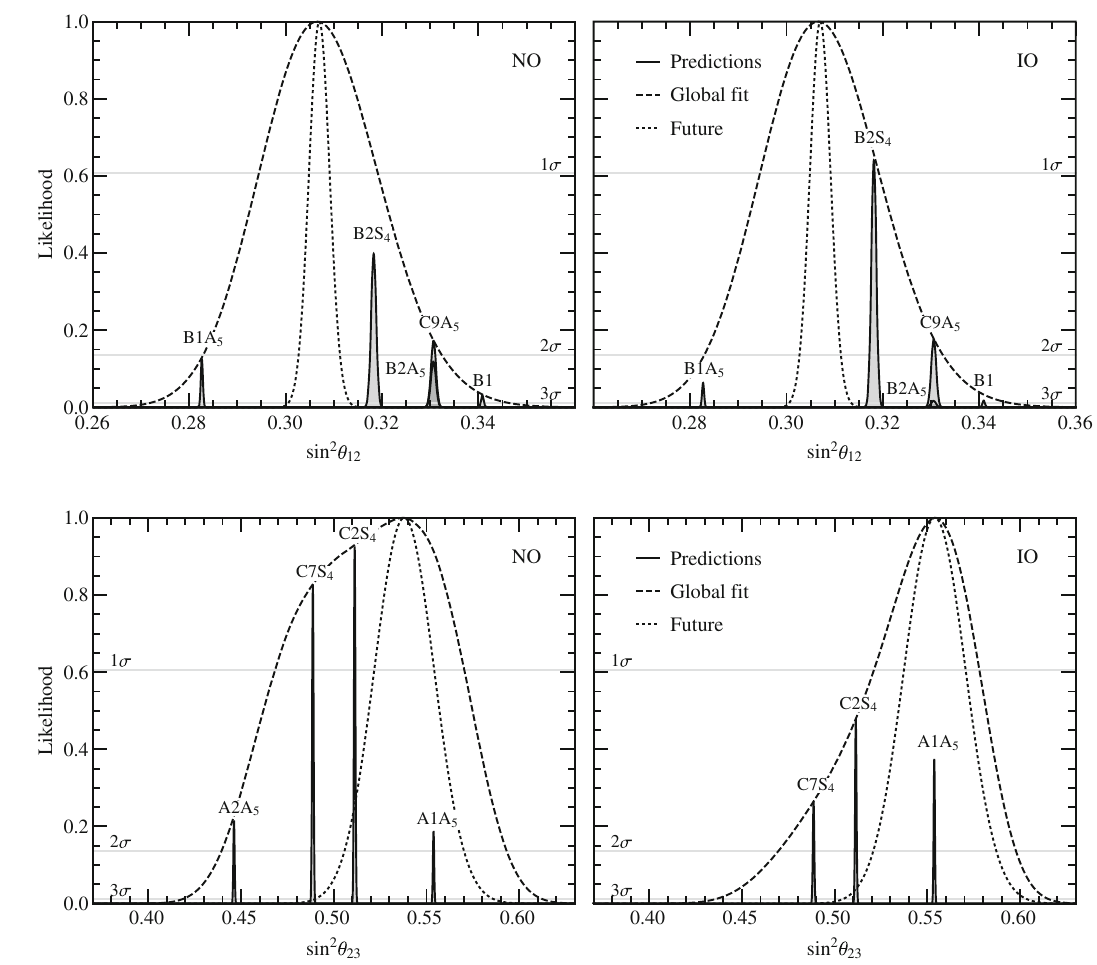
Fig. 4 Upper[lower]panel:predictionsforsin 2 θ 12 [sin 2 θ 23 ]obtained using the current global data on the neutrino mixing parameters. “Future” refers to the scenario with sin 2 θ bf